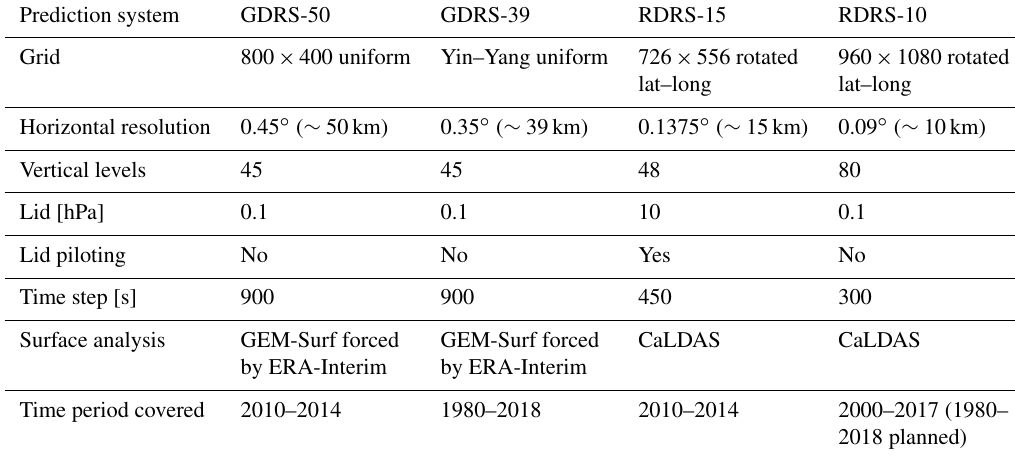
Table 2. Main differences in the configuration of the GDRS and